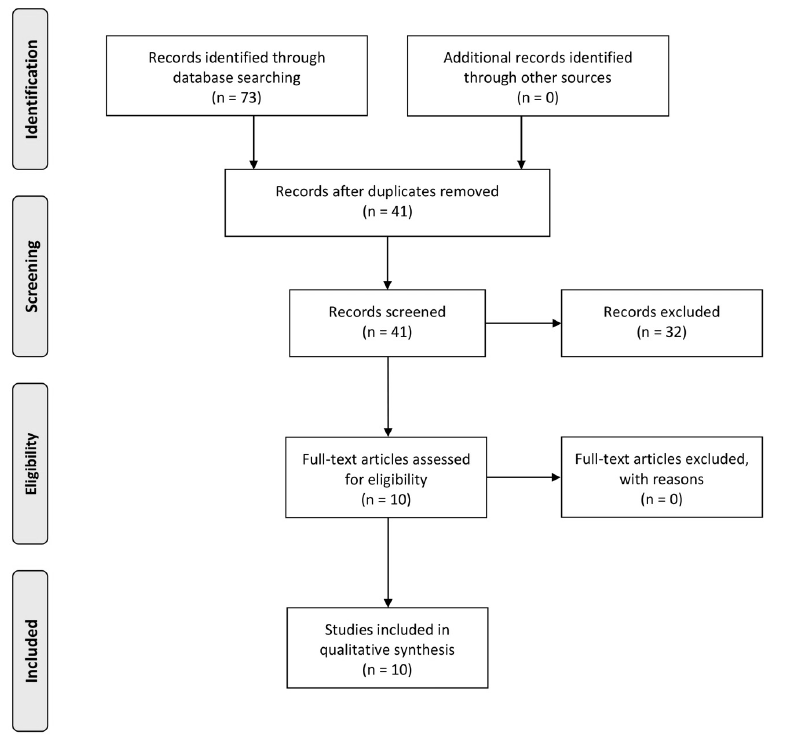
Figure 2. Systematic flow-chart representing study inclusion.